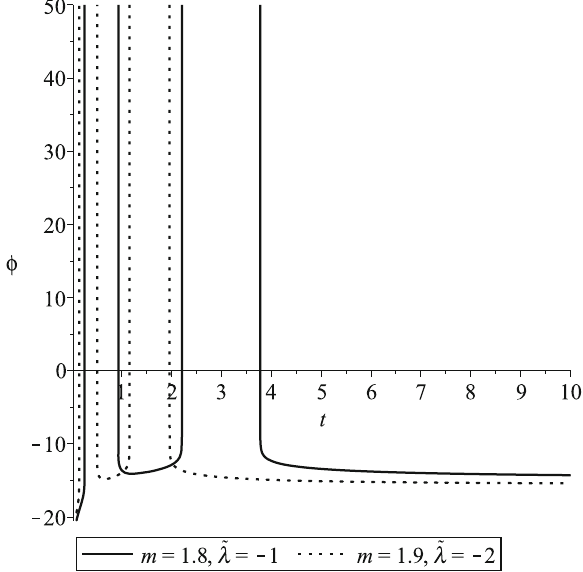
Fig. 8 Evolution of massive scalar field for different values of ˜ λ < 0 and m >